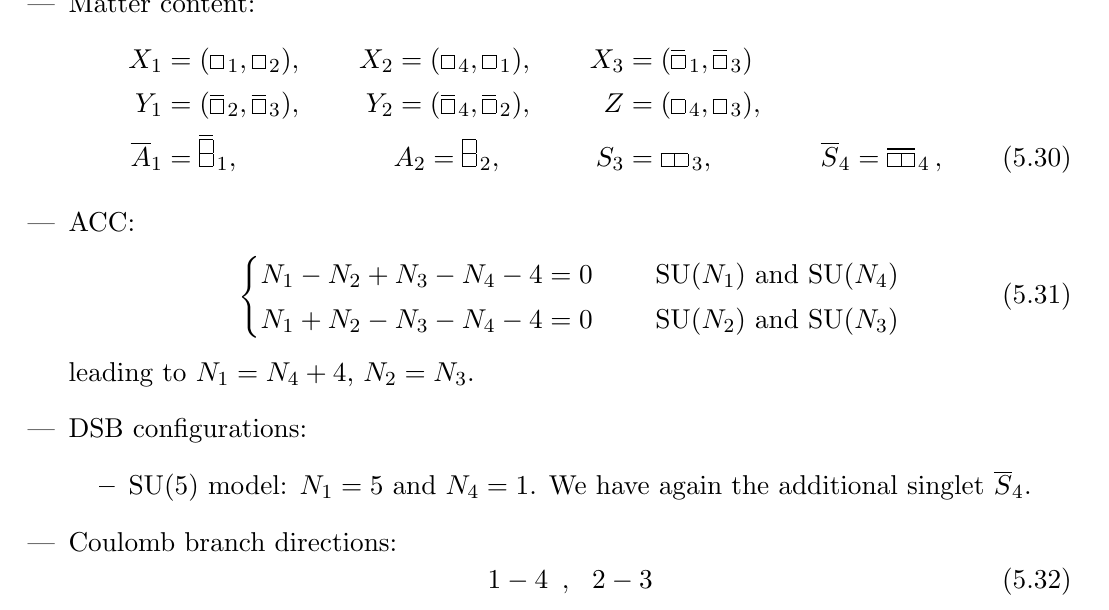
dimer with orientifold b